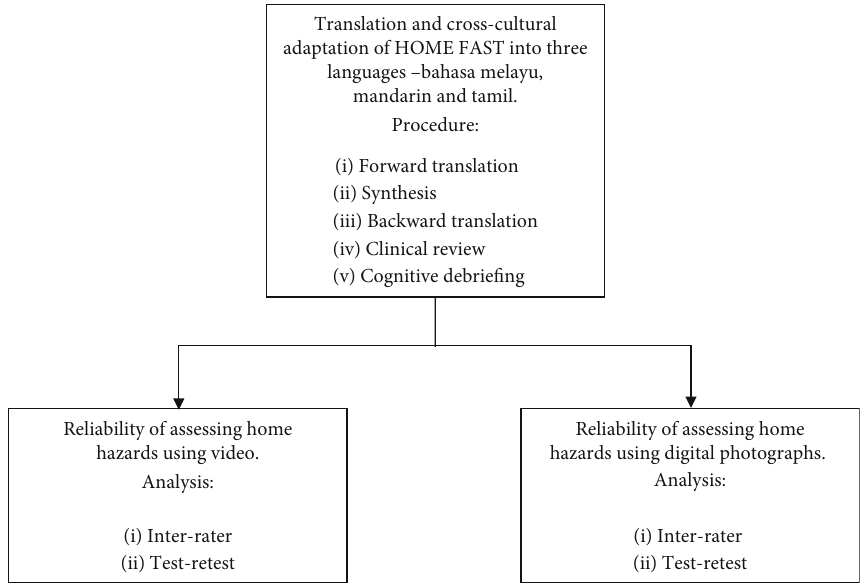
Figure 1: Flowchart of